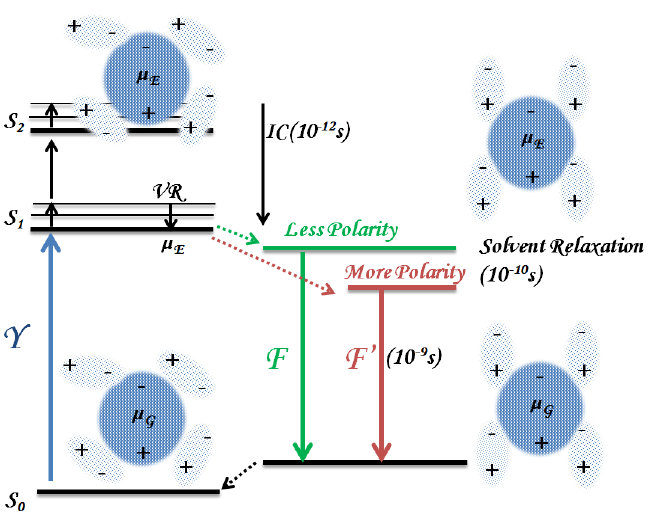
Figure 3. Schematics of solvent relaxation. The excited fluorophores have larger dipole moment ( µ E ) than ground state fluorophores ( µ g ). The solvent relaxation phenomenon is due to the reorientation of solvent molecules surrounding the excited fluorophores. The more polar the solvent is, the further the emission energy is reduced. This leads to solvent-dependent spectral shift and lifetime changes. Fluorescence lifetime can be affected by the increase of non-radiative decay rates in non-solvent environments. VR and IC denote vibrational relaxation and internal conversion. Note that both VR and IC are independent of solvent relaxation because these transitions occur in a shorter time frame (10 −12 s). Non-radiative energy transfer (10 −10 s) and fluorescence (10 −9 s) are then affected by the solvent